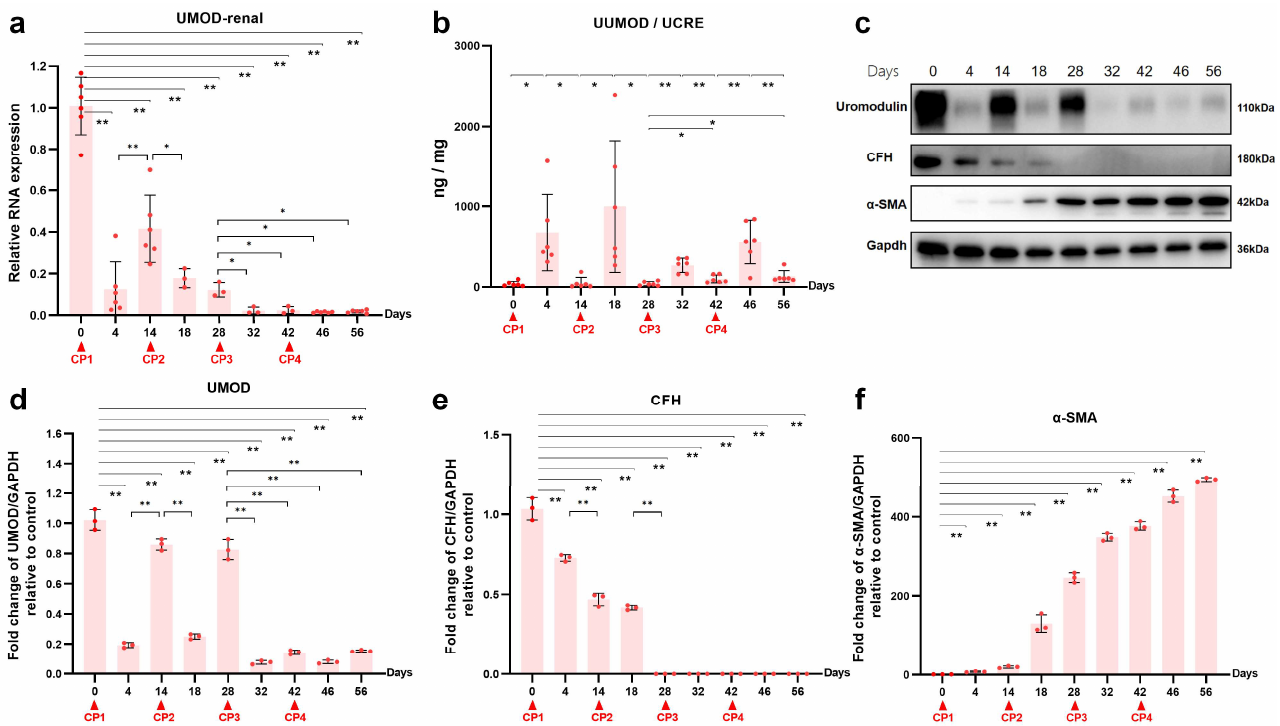
Figure 2. Uromodulin expression during cisplatin (CP)-induced AKI-to-CKD transition in rats. ( a ) Relative expression of uromodulin in kidney after normalization with GAPDH. ( b ) Urinary uromodulin level normalized by UCRE (n = 6). ( c ) Representative Western blots of uromodulin, CFH and α-SMA. The relative protein expression of ( d ) uromodulin, ( e ) CFH and ( f ) α-SMA to GAPDH at different time points (n = 3). Data are presented as means ± SD. * p < 0.05 and ** p < 0.01 between the two groups.